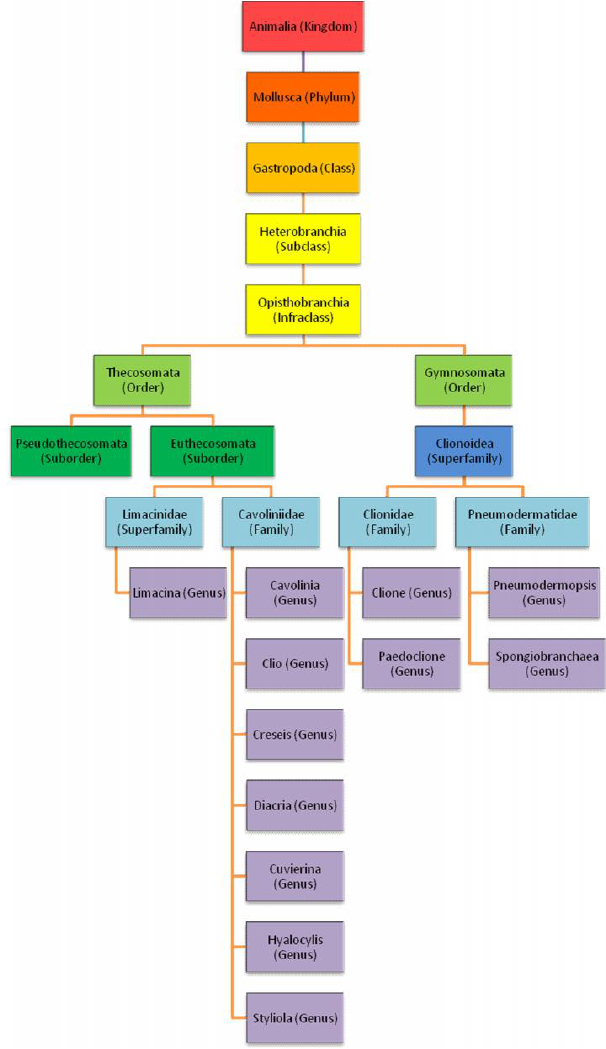
Figure 3. Taxonomy of